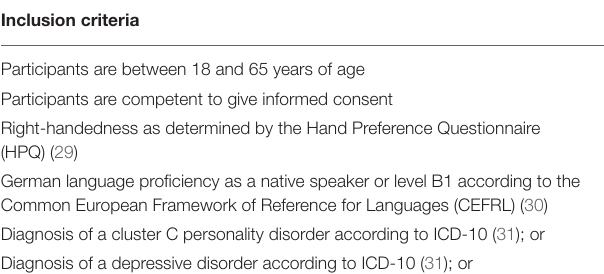
TABLE 1 | Inclusion and exclusion criteria for trial